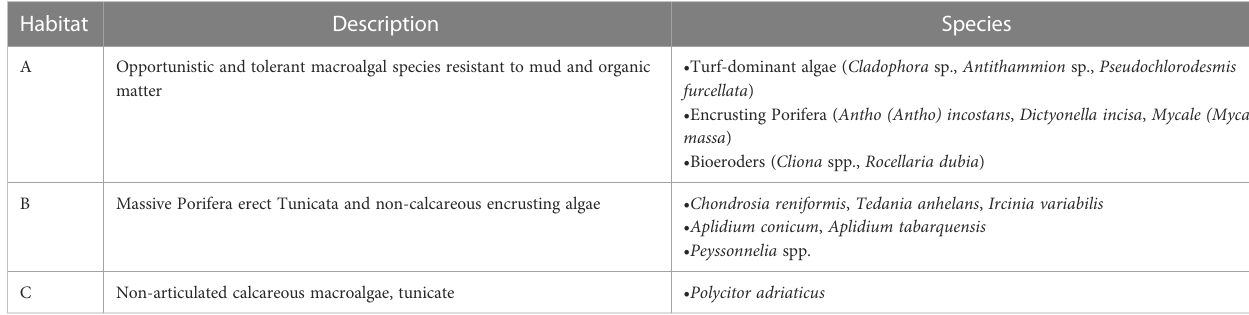
TABLE 1 Habitat assemblages description extrapolated by Falace et al. (2015).